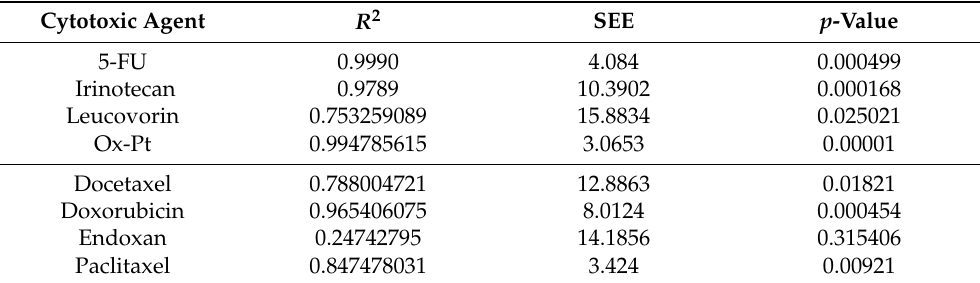
Table 1. R 2 values, standard error of the estimate (SEE), and p -values for all drugs and for both cancer cell